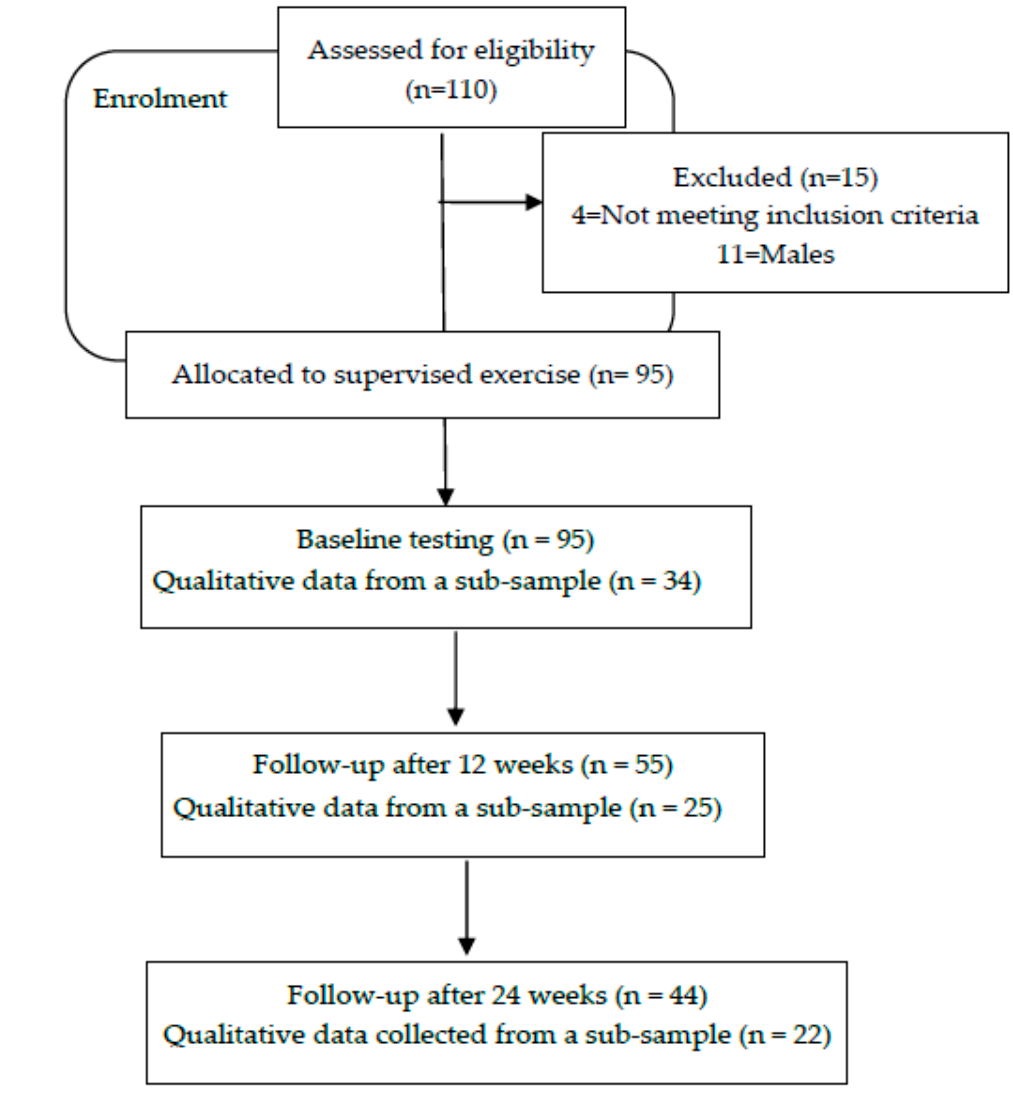
Figure 1. Flow diagram of study participants in the exercise intervention indicating the sample size of the qualitative and quantitative arms of this study.